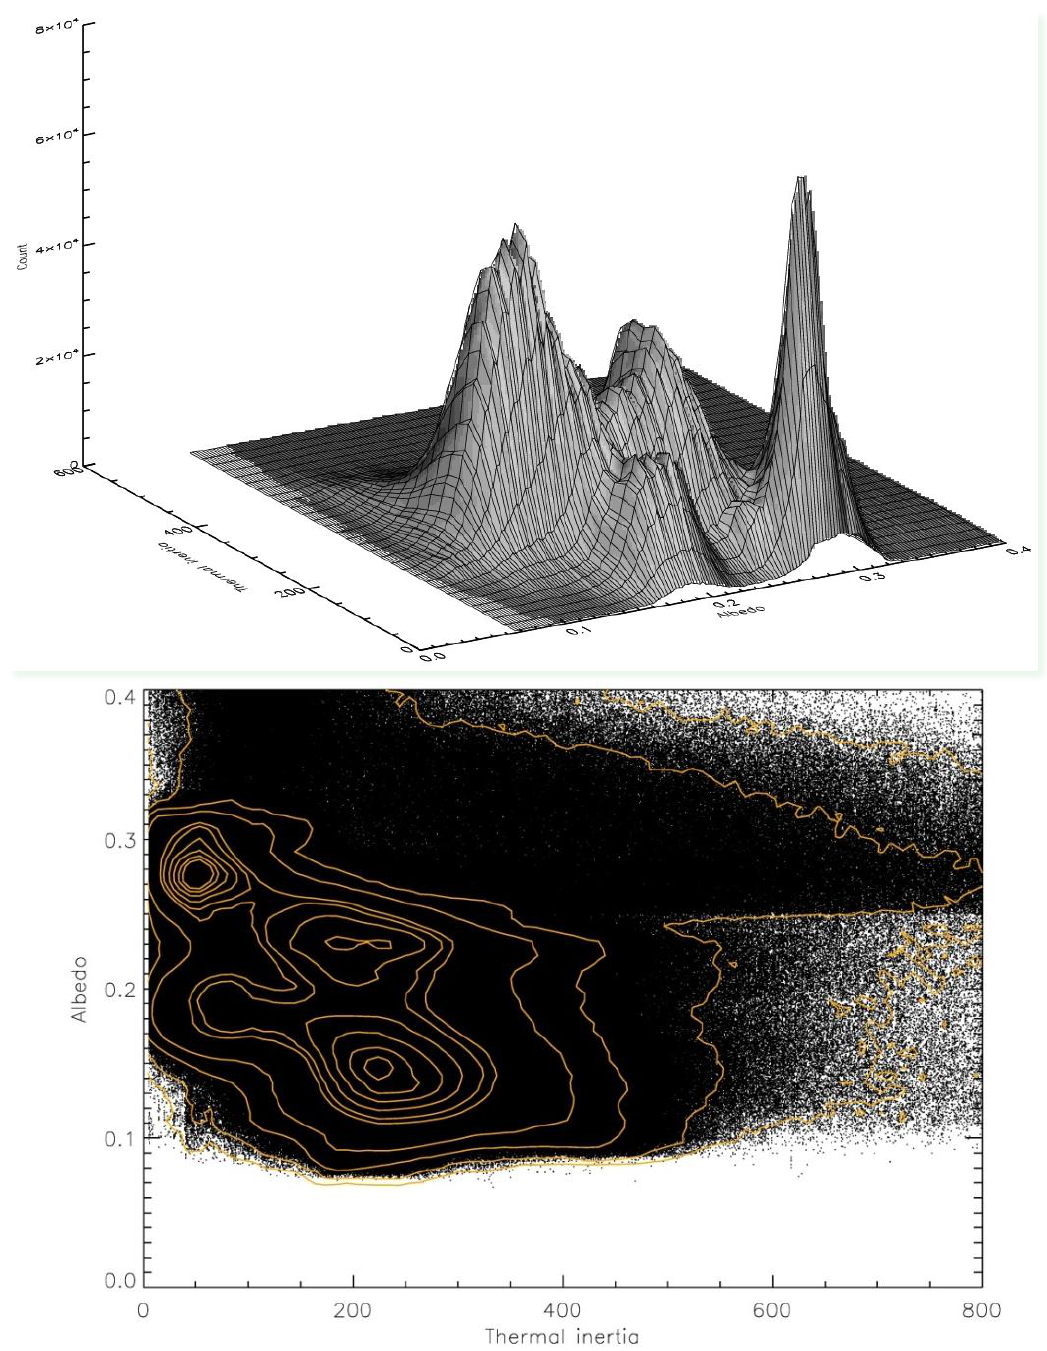
Figure 1. The thermal emission spectrometer (TES) albedo and thermal inertia datasets used in this study. ( Top ): histogram shows all 2.592 × 10 7 pixels within the albedo (x-axis) and thermal inertia (y-axis, into the page) data. Vertical z-axis gives the pixel counts. Four peaks can be clearly seen, centred at (albedo, thermal inertia) values of (0.15, 225), (0.23, 210), (0.27, 55) and (0.19, 55), indicating that the majority of data points fall into four major groups. ( Bottom ): a scatterplot with contours, focused on the primary data values of interest to Martian surface scientists. Binsize for contours is 10.0 in thermal inertia and 0.005 in albedo. Contours are placed at counts: 40, 2 × 10 2 , 1 × 10 3 , 3 × 10 3